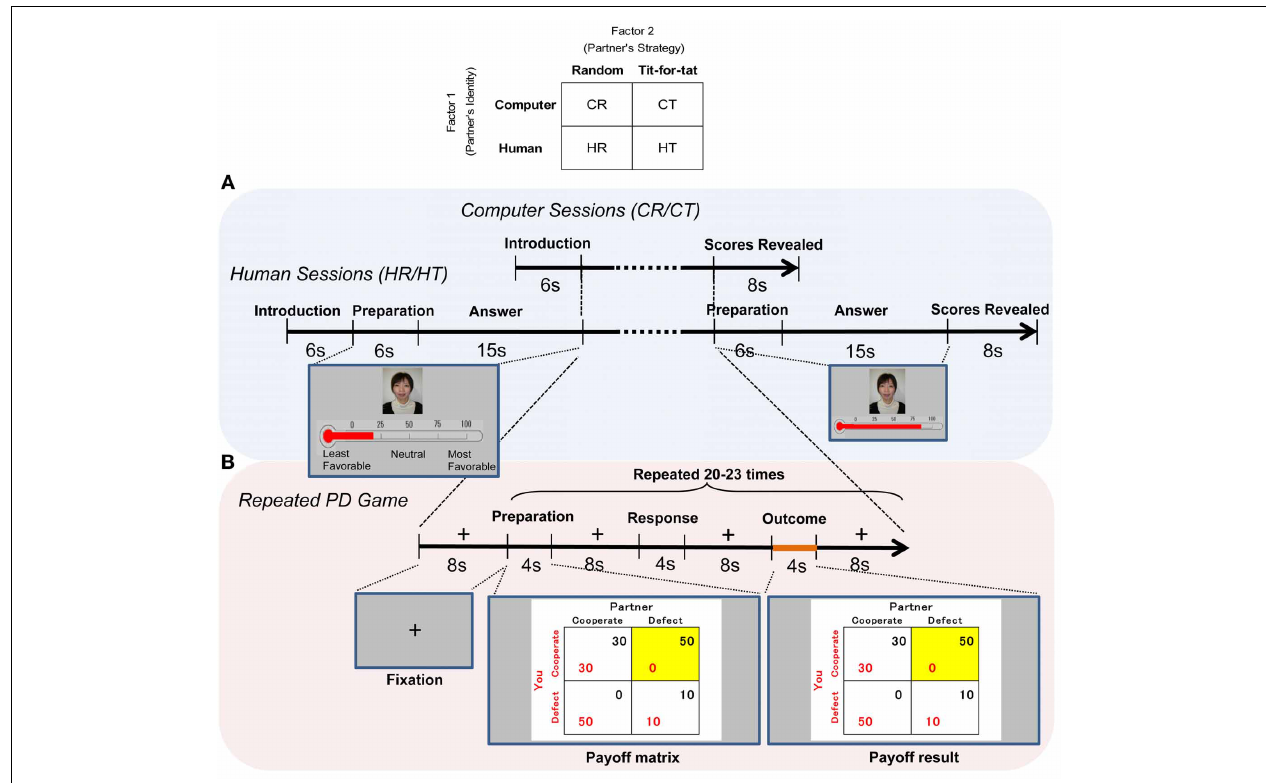
FIGURE 1 | Time course of the fMRI experiment. (A) After their partner was introduced, the subjects played 20–23 rounds of the prisoner’s dilemma game, and both players’ scores for the session were displayed on a screen for 8s at the end of each of four sessions (CR/CT/HR/HT). Before and after the games with humans, the subjects viewed a picture of a same-sex partner displayed on the screen for 6s and rated their preference on a thermometric